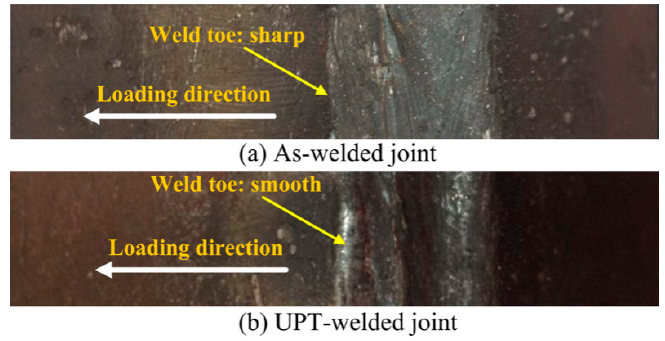
Figure 7. Stress concentration of ( a ) an as-welded joint; and ( b ) UPT-welded joint.